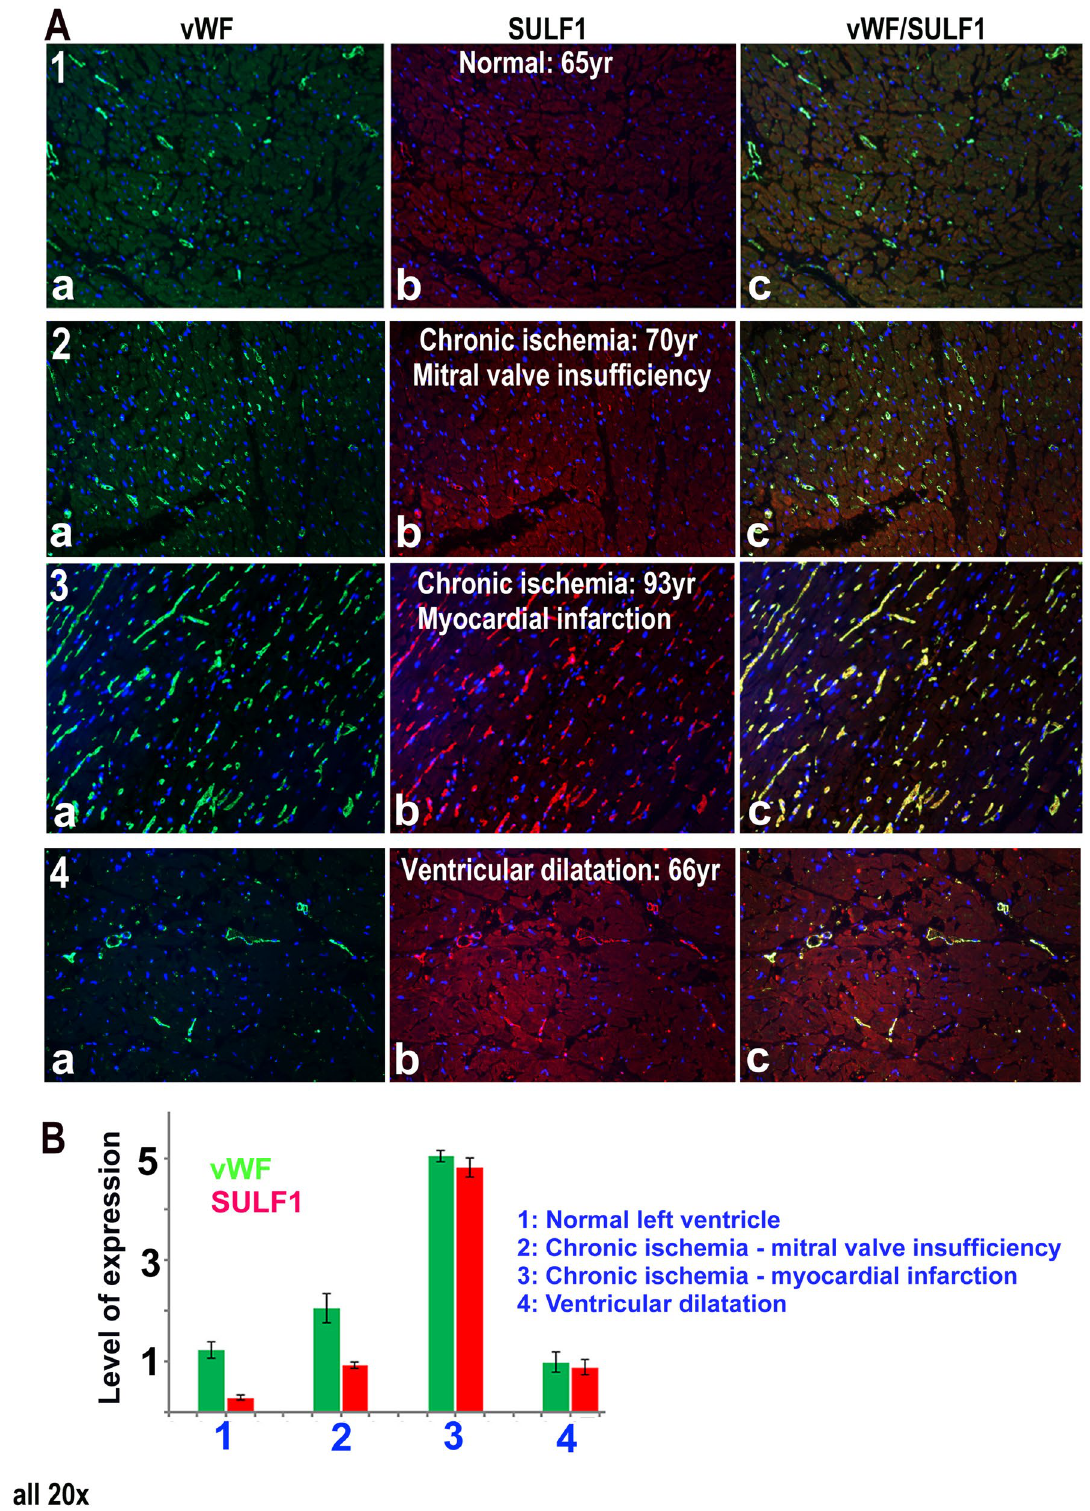
Figure 4. (A) Levels of vWF and SULF1determined by double immunofluorescence in normal (1) and ischemic heart due to mitral valve insufficiency (2) or myocardial infarction (3) and during ventricular dilatation (4). (B) Quantification of vWF and SULF1 expression levels using volocity